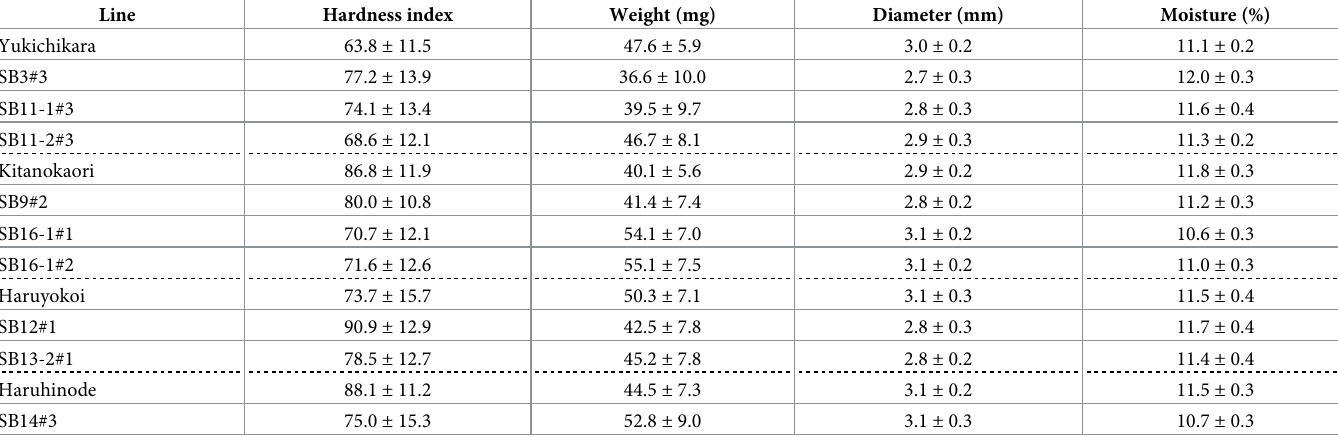
Table 3. Grain-related traits measured by SKCS in the selected early flowering lines and their four parental